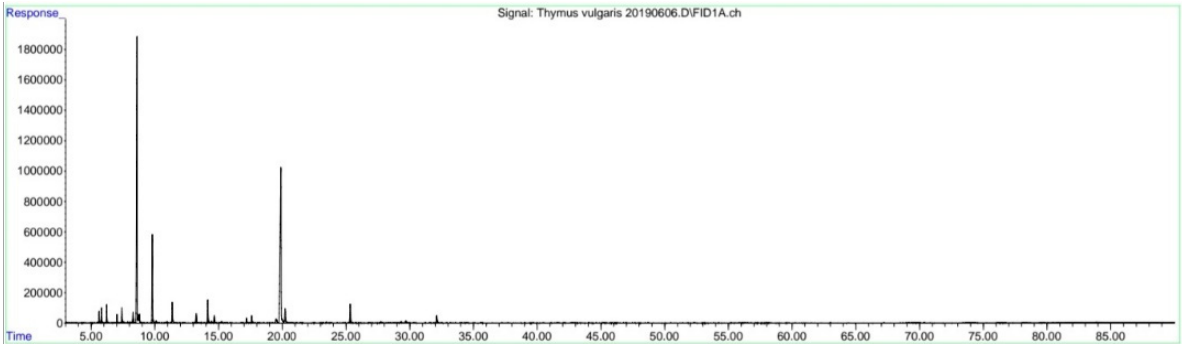
Figure 2. GC-FID chromatogram of T. vulgaris hydrolate.